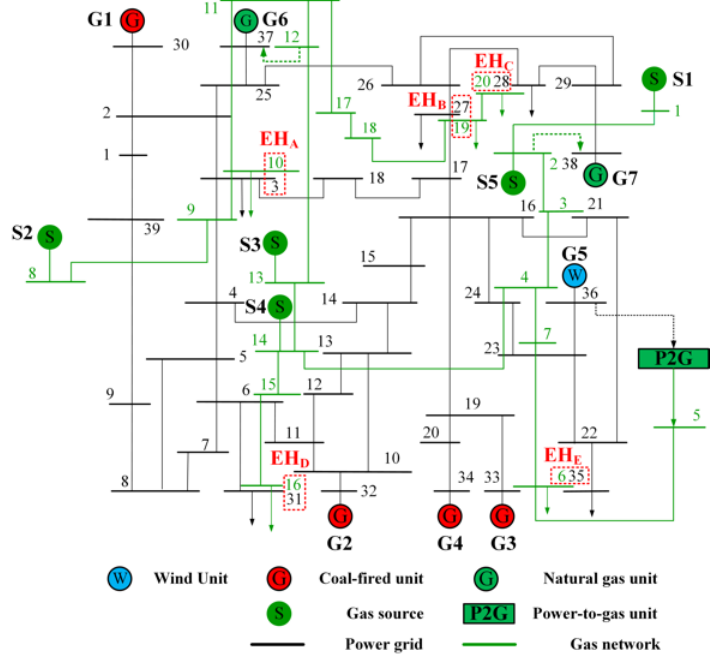
Figure 4. The modified IEEE 39-bus power system and the Belgian 20-node gas system. Table 1. Parameters of the thermal power units.